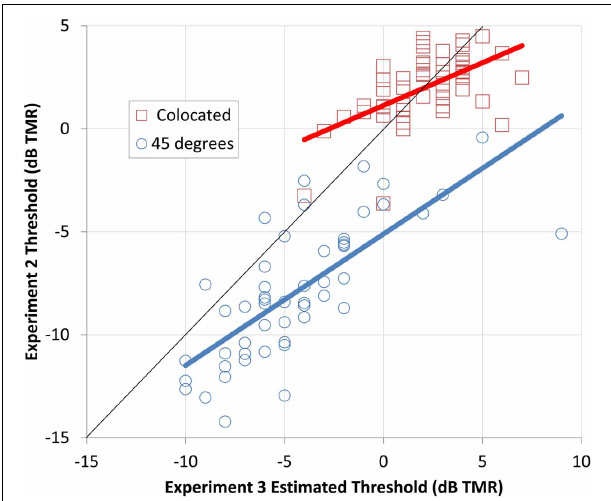
FIGURE 6 | The thresholds obtained in Experiment Two (y axis) for the male target and male maskers are plotted relative to the thresholds estimated from the progressive tracks used in Experiment Three (x axis). The squares indicate the thresholds for the colocated conditions and the circles indicate the spatially separated condition. Best-fitting linear predictors are shown as thick red (colocated) and blue (spatially separated)